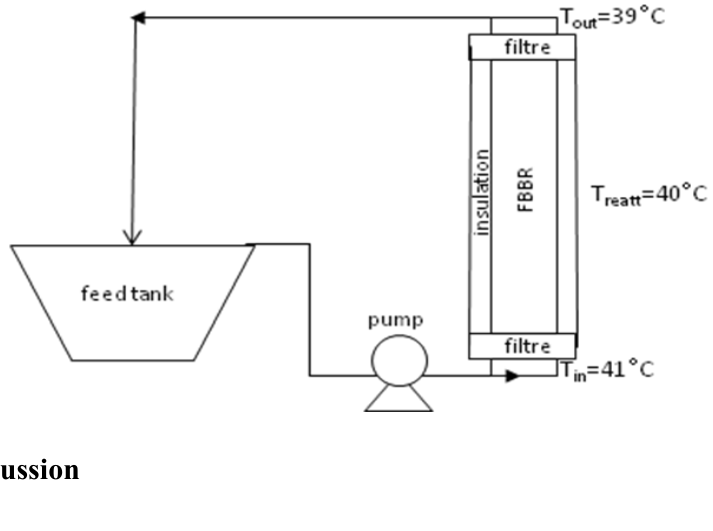
Figure 1. Schematic representation of experimental apparatus.